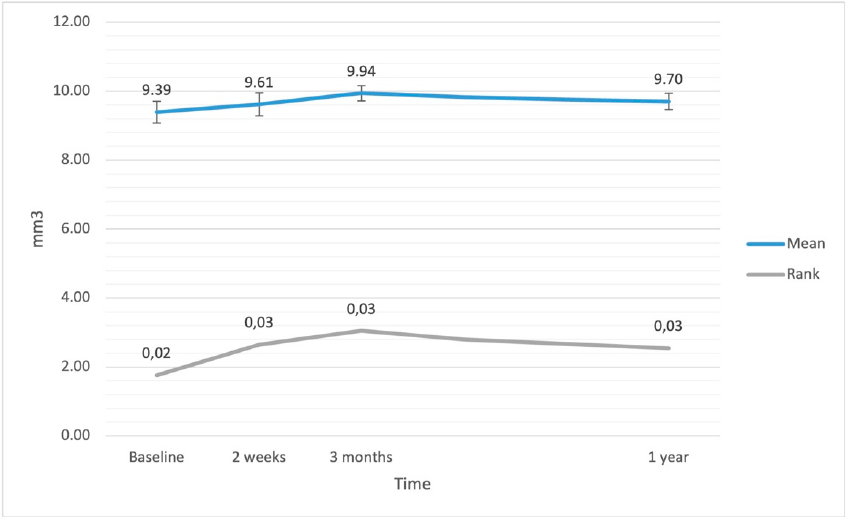
Figure 3. Cube volume (CV; retinal volume within central 6 mm circle) at baseline and after the surgery. The error bars represent 95% CI of the obtained results. surgery. The error bars represent 95% CI of the obtained